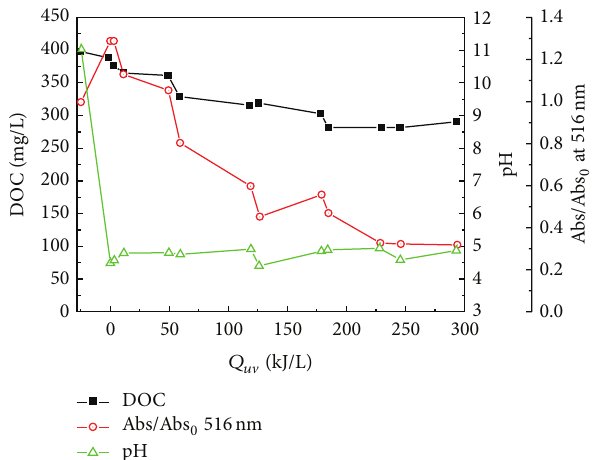
Figure 6: Decolourisation and mineralization of the textile wastew- aterbyTiO 2 solarphotocatalysis:DOCdegradationcurve,Abs/Abs 0 AT516nmandpHevolution.(Figure6isreproducedfromreference [26]. Copyright 2011, with permission from Elsevier).